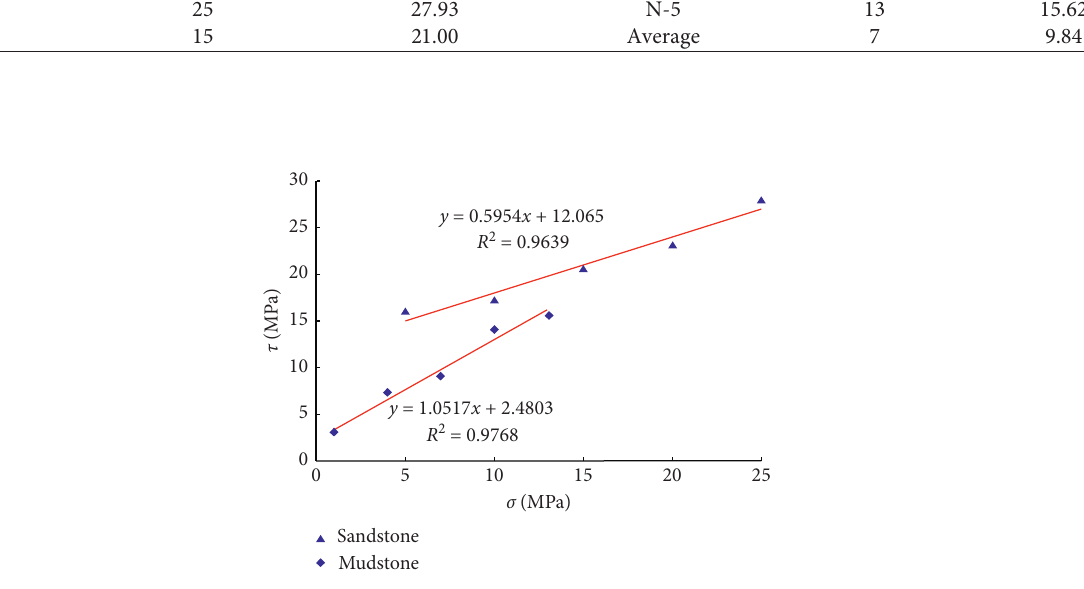
Figure 3: Relationship between shear strength and normal stress.